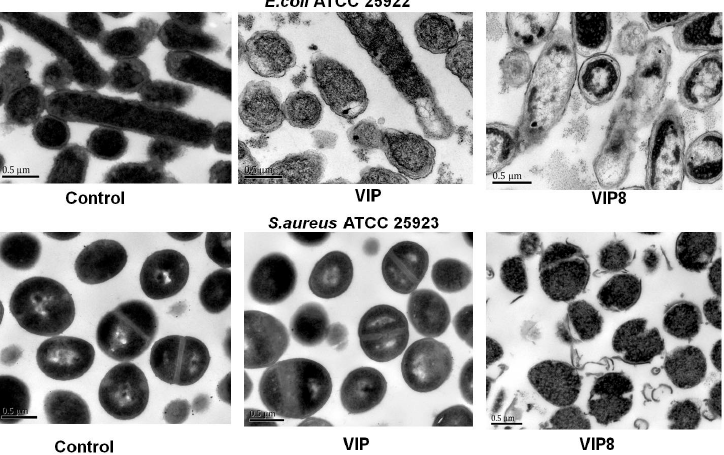
Figure 1. Antimicrobial mechanism of VIP and the VIP analogue 8. Transmission electron micrographs of E. coli ATCC 25922; Transmission electron micrographs of S. aureus ATCC 25923; bacteria in mid-logarithmic growth were treated with peptides at 1 × MIC for 2 h.